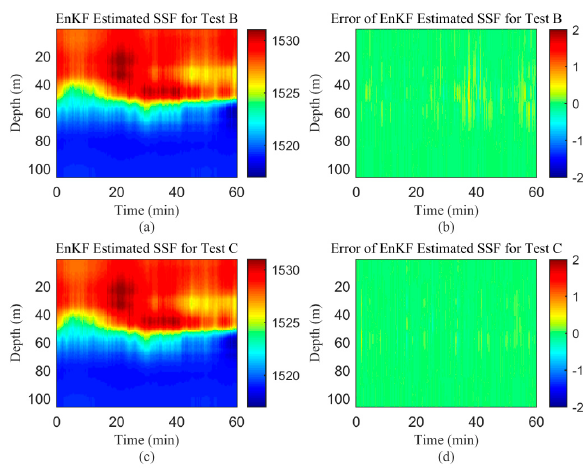
Figure 6. Inversions of the time-evolving SSF for Test B and Test C. ( a , c ) represent the EnKF estimation results for test B and C respectively; and ( b , d ) are the relative errors.